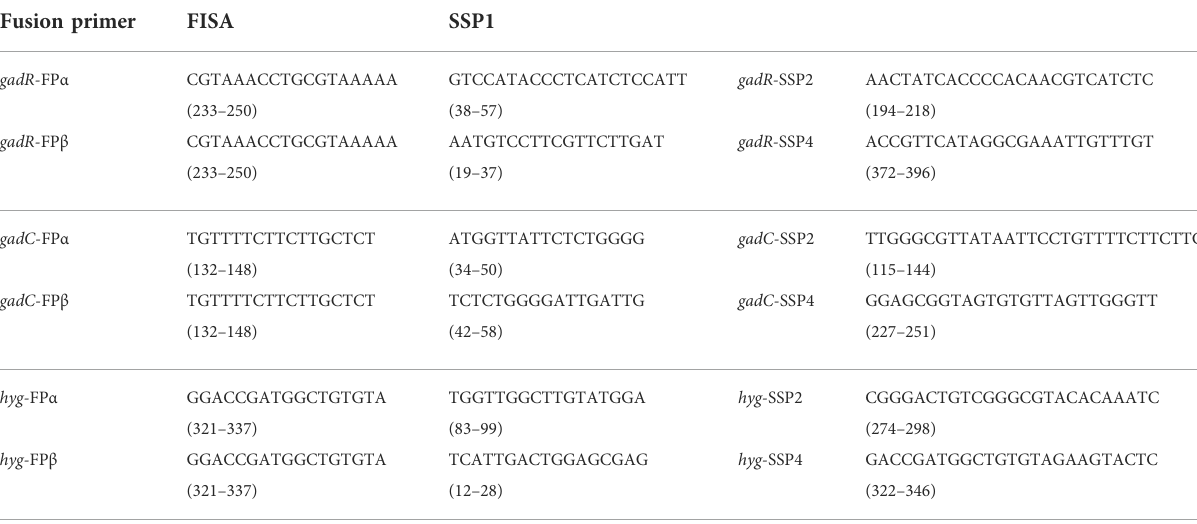
TABLE 1 Primers used in this